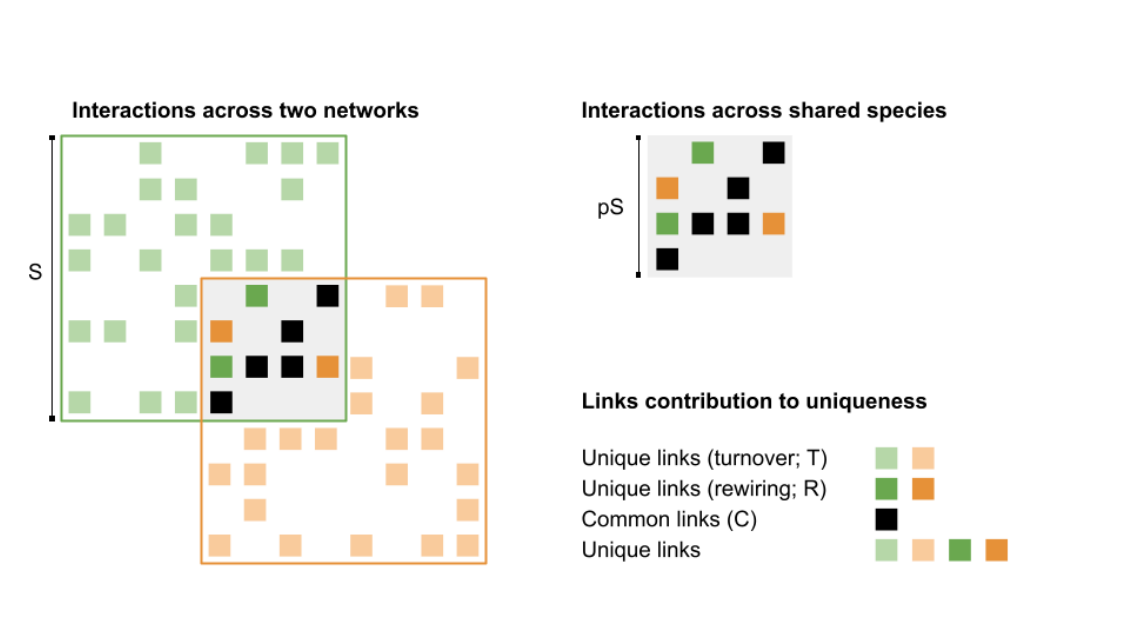
Figure 1 – The dissimilarity of two networks (green and orange) of equal richness S (this also holds for unequal richness) depends on three families of interactions: those that are unique because of species turnover (in a pale color), those that are unique because of rewiring (in a saturated color), and those that are shared (in black). Assuming that the chance of sharing a species between the two networks is p , then there can be at 2 S 2 shared links – for this reason, overall network dissimilarity ( β wn ) will have a most p × component tied to species turnover, which is β st